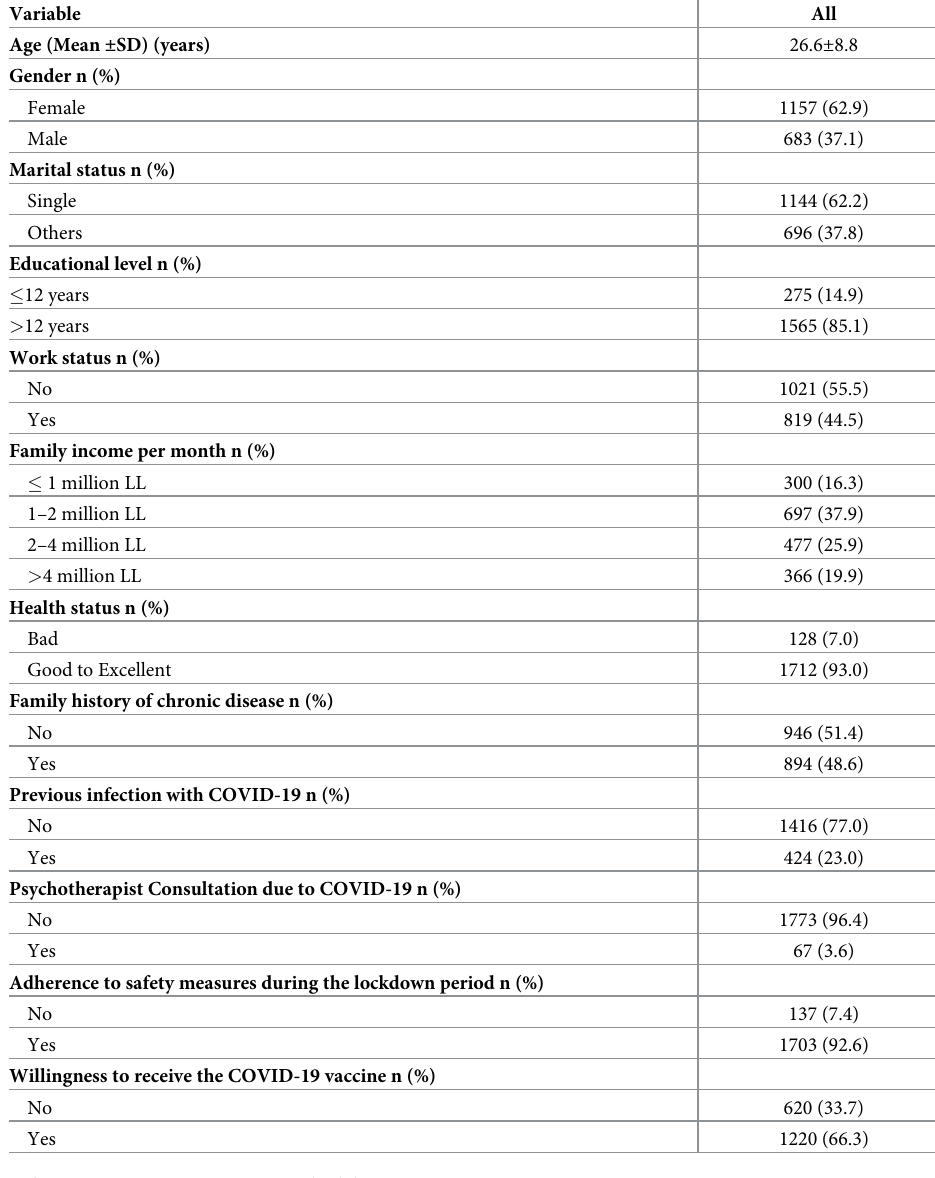
Table 1. Baseline characteristics of the study participants (N =